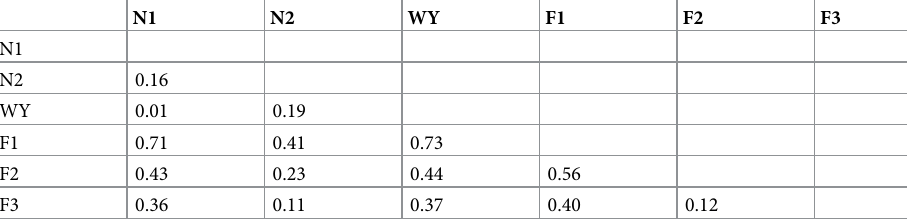
All values show significance at P �